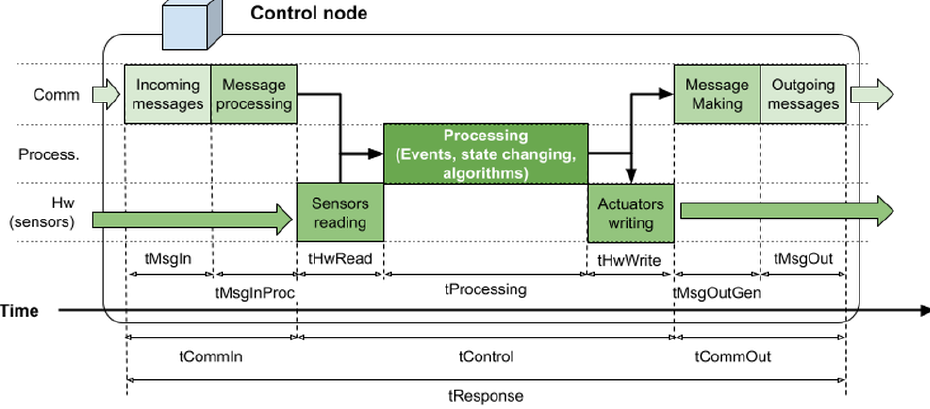
Figure 2. Times related to communications and processing of a single control node